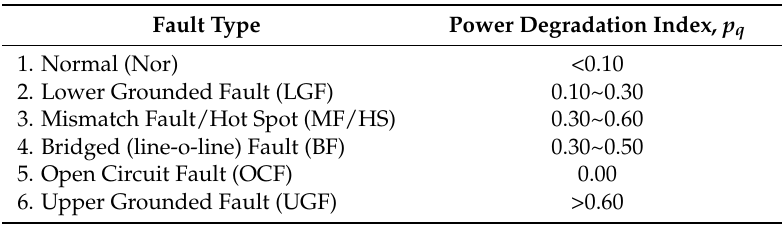
Table 1. The output power degradation for different fault types [6,11].